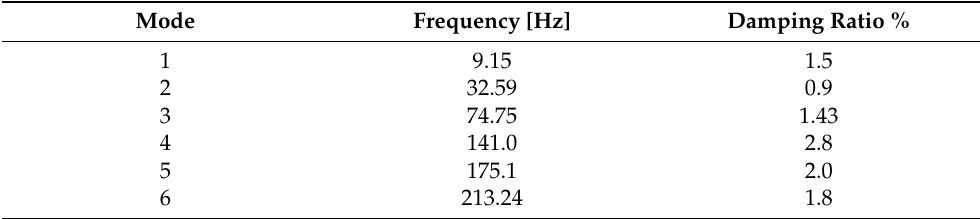
Table 2. Offline modal parameters estimation, averaged peak picking, and rational fractional polyno- mial (RFP)